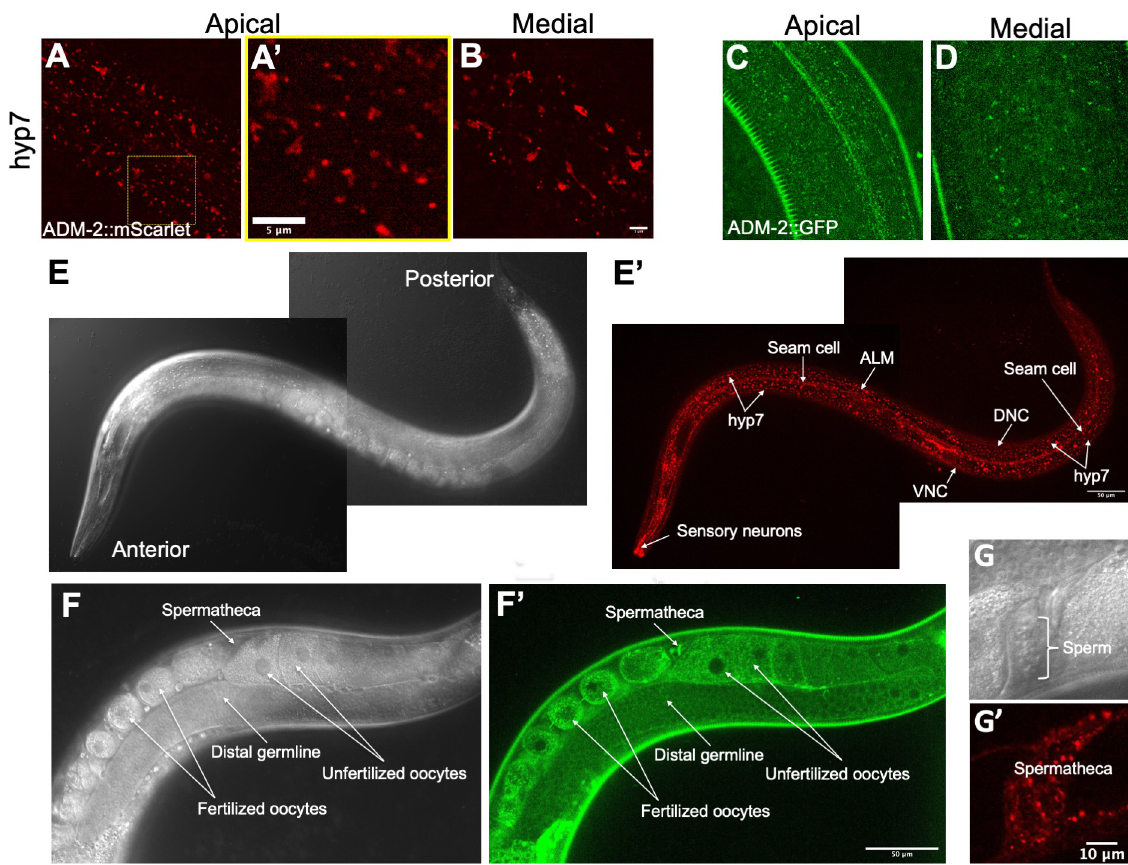
Fig 2. Expression of endogenously tagged ADM-2. (A–D and A’) Representative confocal images of ADM-2 expression in the C . elegans hyp7 region. ADM-2::mScarlet (A, B) and ADM-2::GFP (C, D) expression at apical (A, C) and medial (B, D) planes. A’ is the inset from panel A. Bar in B = 5 μ m (for A–D); in inset A’ = 5 μ m. (E–G and E’–G’) Representative DIC (E–G) and confocal (E’–G’) images of ADM-2 expression. ADM-2::mScarlet in the hyp7 hypodermis; seam cells; sensory neurons; and ALM, DNC, and VNC neurons (E, E’) and in spermatheca (G, G’). ADM-2::GFP expression in the distal germline, oocytes, and spermatheca (F, F’). Bar in E’ = 50 μ m (for E, E’); in G’ = 10 μ m (for G, G’); in F’ = 50 μ m (for F,